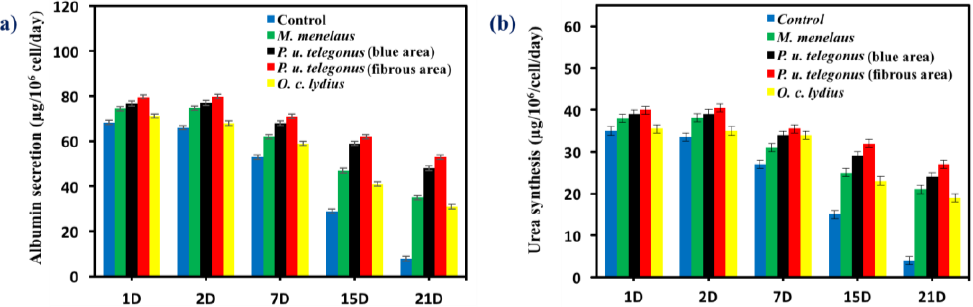
Figure 7. Liver-specific functions of hepatocytes cultured on different substrates during 21 days (D) of cell culture, including ( a ) albumin secretion and ( b ) urea synthesis. Data are shown as mean ± standard deviation.